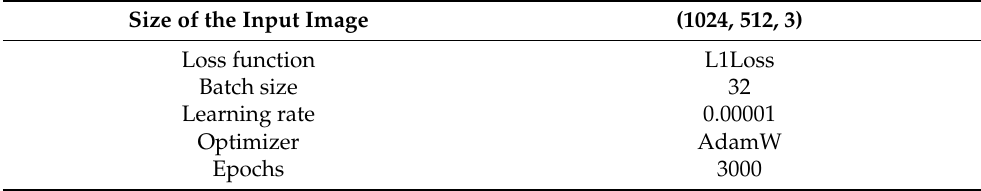
Table 1. Hyperparameters in the